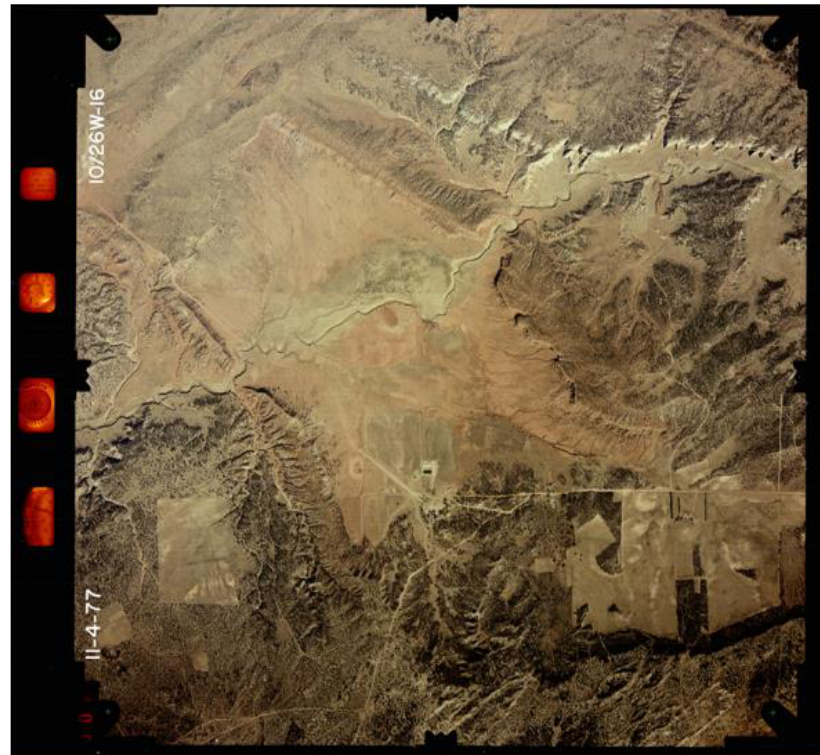
Figure 7. An example of printed (hardcopy) panchromatic historical aerial photos. This photo was collected on 13 June 1979 and it has a scale of 1:4000. It shows ground features in gray-scale.